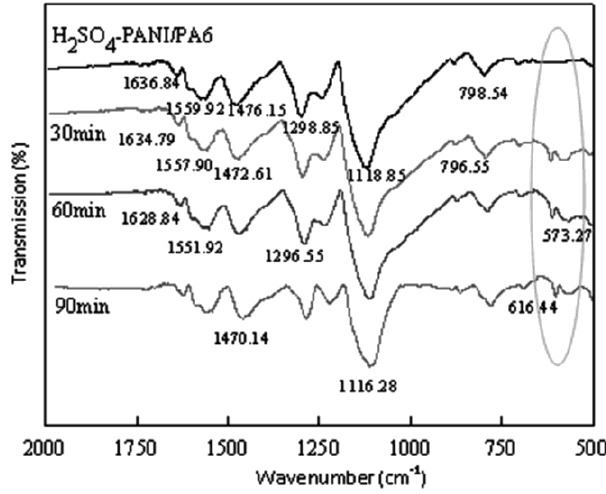
Figure 5. FTIR spectra of PANI/PA6 and TiO and 90 min,